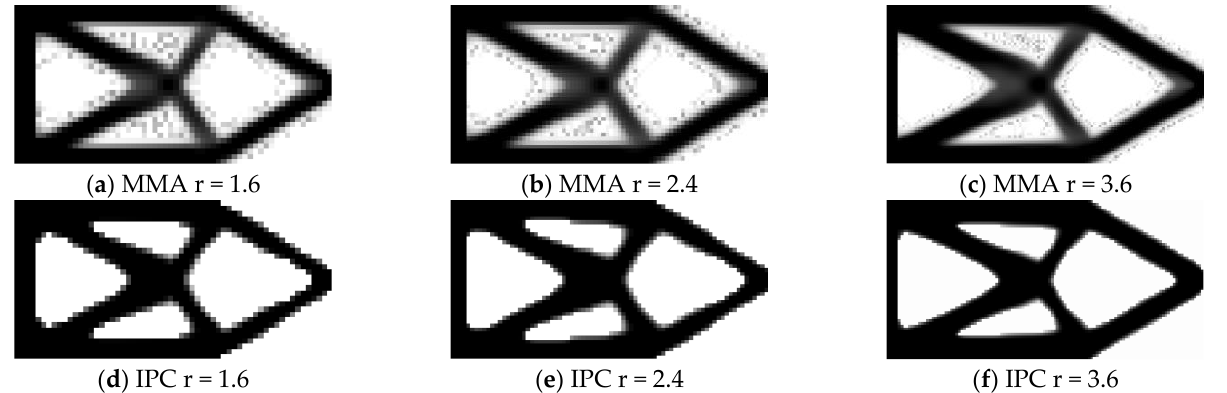
Figure 7. Optimized designs of the cantilever beam using IPC and MMA methods.